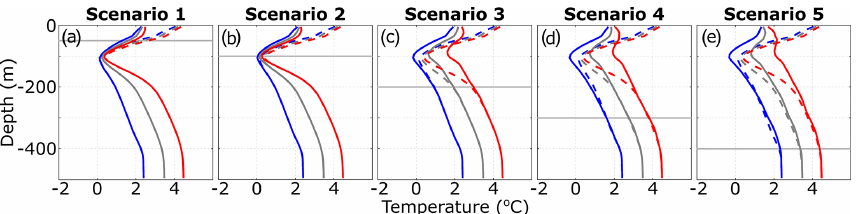
Figure 6. Steady-state glacier-adjacent water temperature for a range of initial Atlantic Water conditions and with a flat-bottomed domain. In all plots, solid and dashed lines indicate simulations with and without icebergs, respectively. Grey, blue and red lines show scenarios using the BCstandard , AWcool and AWwarm boundary conditions, respectively (shown in Fig. 1f). The horizontal grey lines indicate the maximum iceberg keel depth in each scenario.